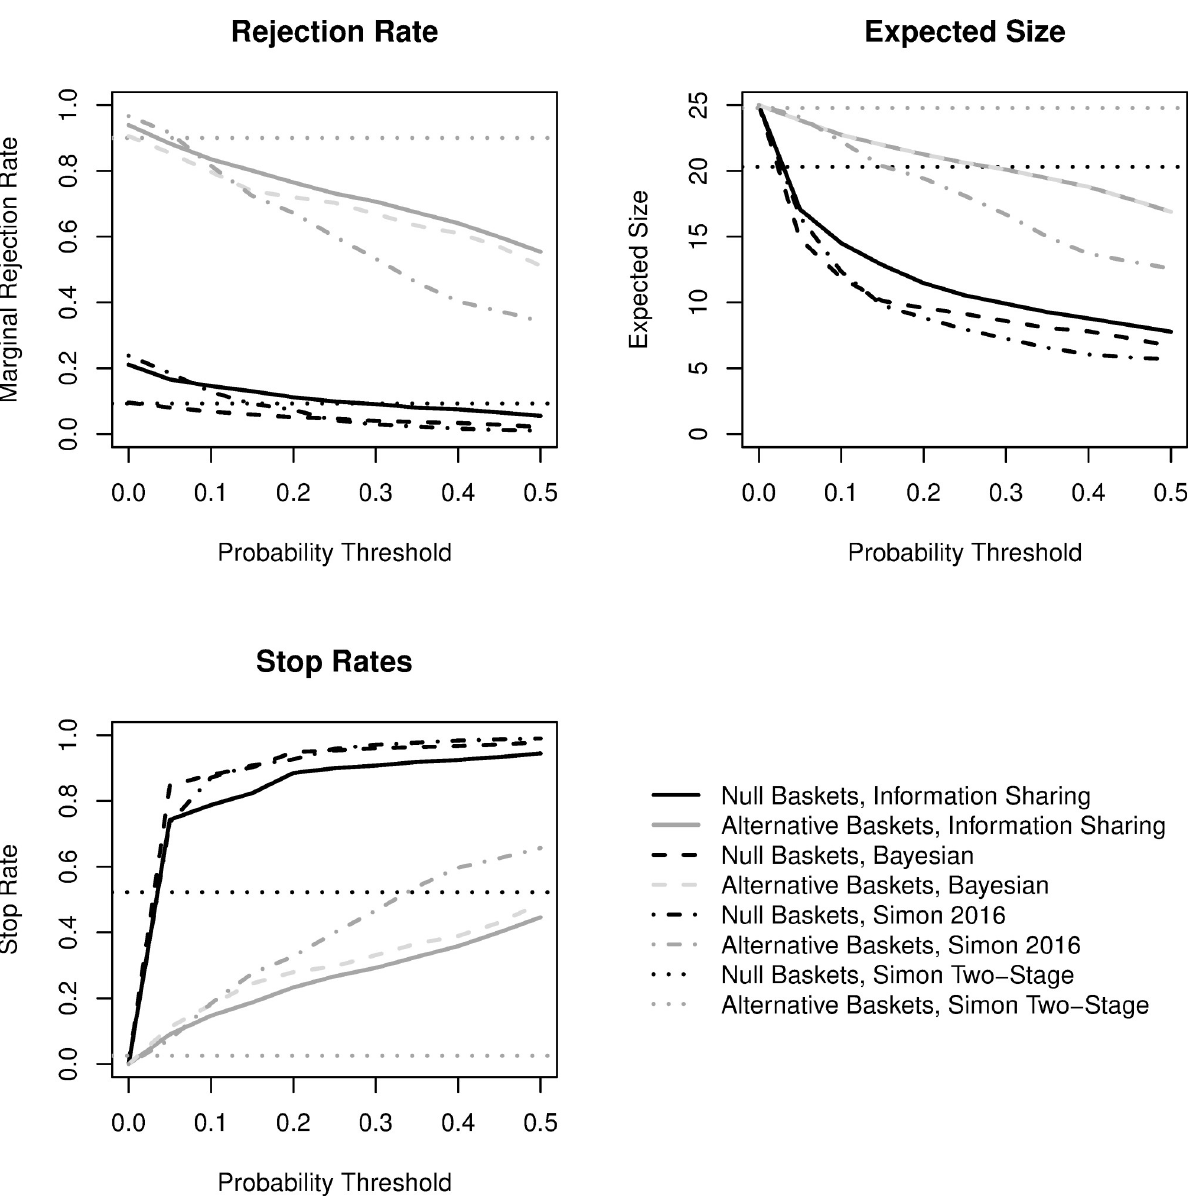
Fig 4. Comparisons of trial operating characteristics for equally mixed scenario (5 null, 5 alternative baskets). Black coloring is for null baskets and gray coloring for alternative baskets. The dotted lines represent Simon’s two-stage minimax design, dashed lines represent a design with interim monitoring after each participant based on Bayesian predictive probability futility monitoring, dashed-dotted lines represent Simon’s (2016) design with information sharing with posterior probability futility monitoring, and the solid lines represent a Bayesian design that also facilitates information sharing across baskets based on exchangeability of the response rate with predictive probability futility monitoring. The rejection rate summarizes the proportion of baskets across the 1000 simulated trials where efficacy was concluded, the expected sample size presents the average number enrolled in a given null or alternative basket, and the stop rate describes the proportion of baskets that terminated early at any point for